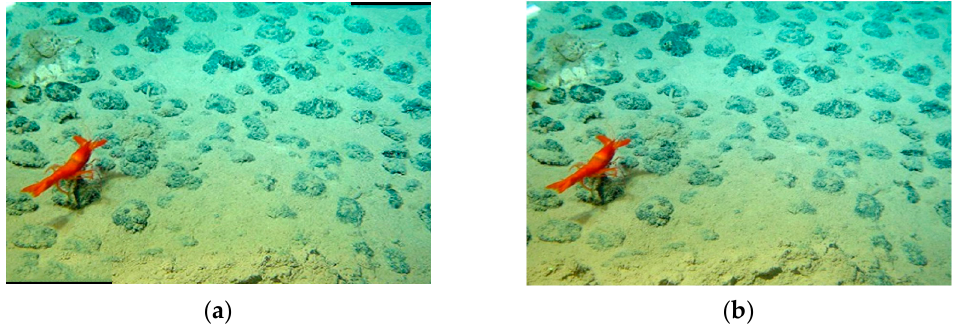
Figure 17. The fusion images for T3: ( a ) I-RANSAC; ( b ) IIR. For the same underwater image, the image fusion of T3( a ) can see the stitching trace, while the fusion trace of T3( b ) disappears.